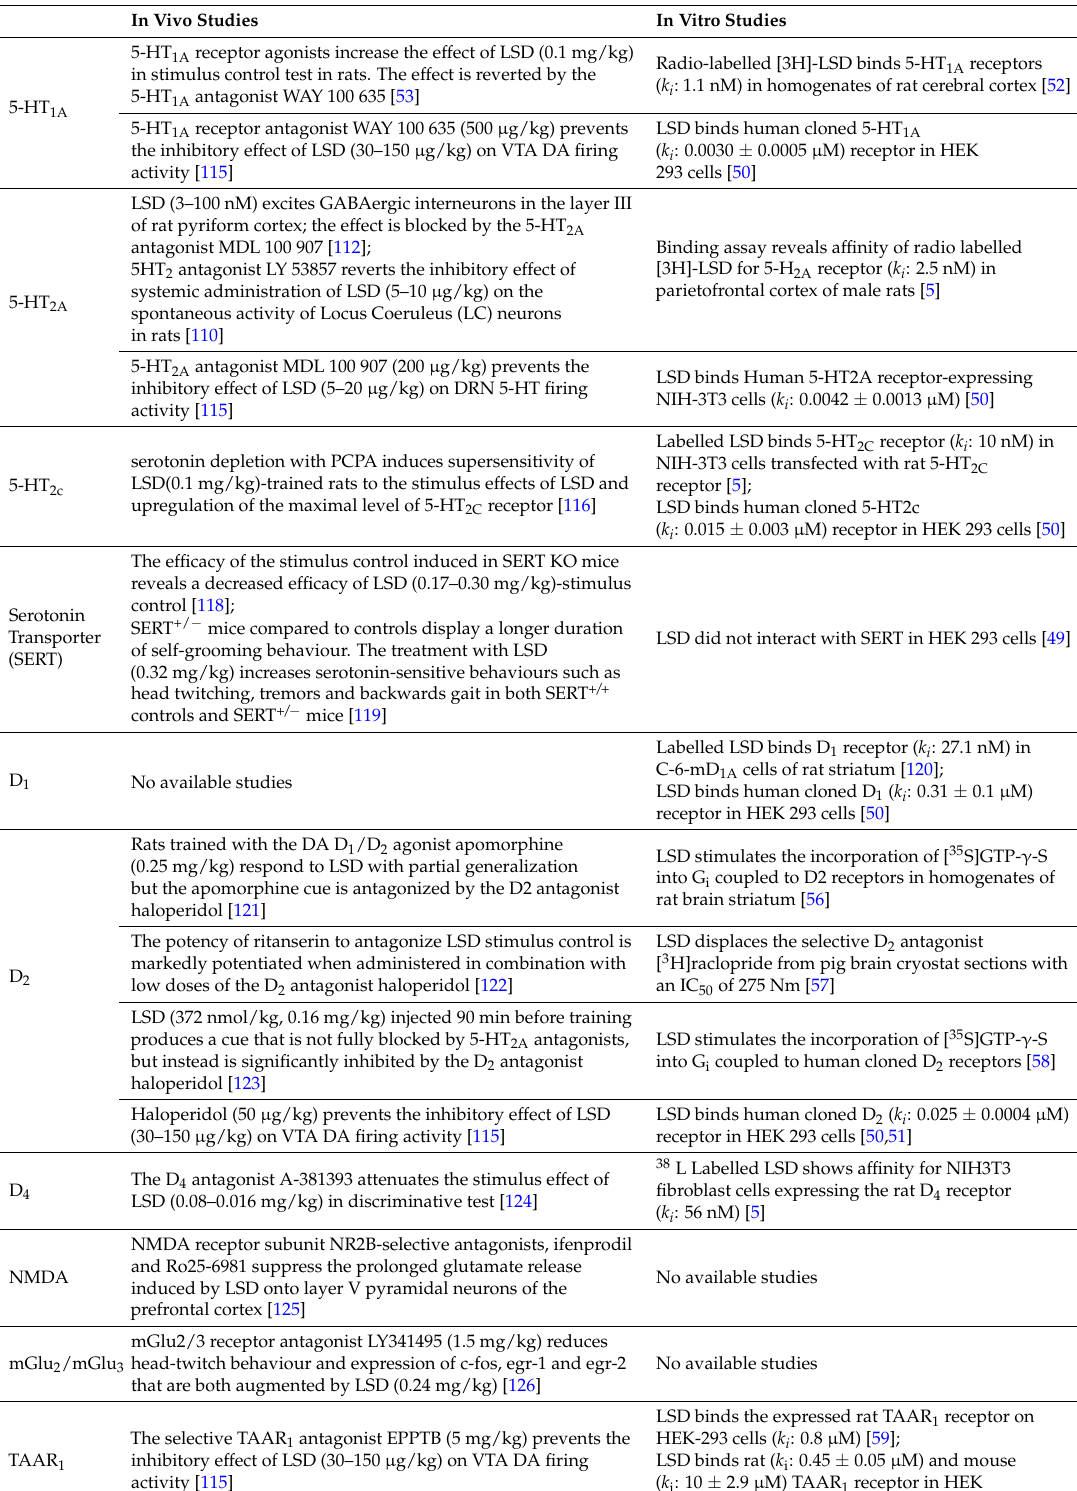
Table 2. Summary of the experiments showing the interaction of LSD with serotonergic, dopaminergic, glutamatergic and TAAR